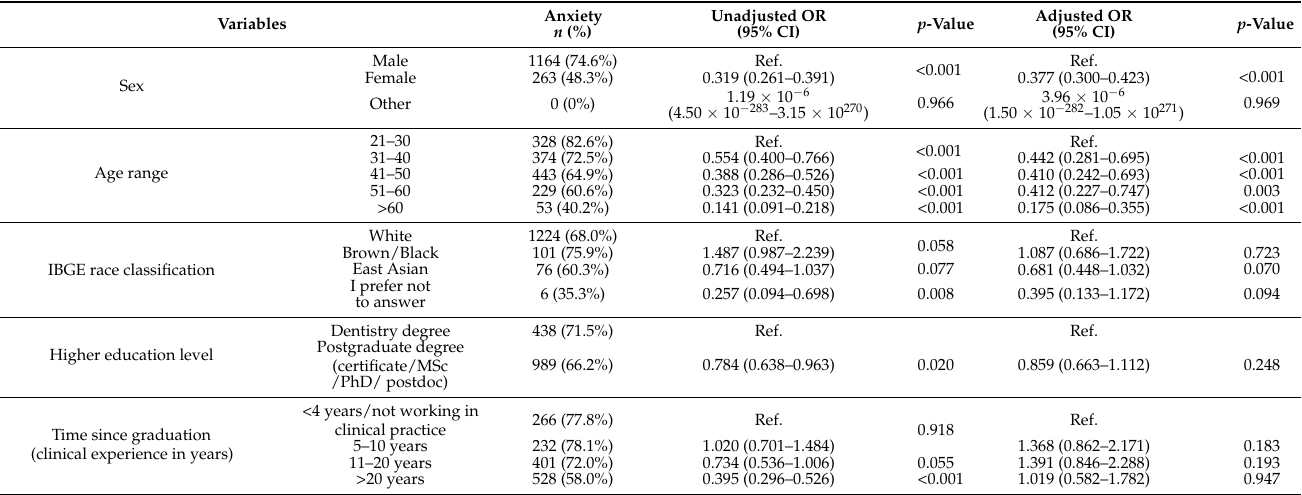
Table 2. Descriptive and logistic regression analysis (odds ratio; 95% confidence interval) of anxiety and independent